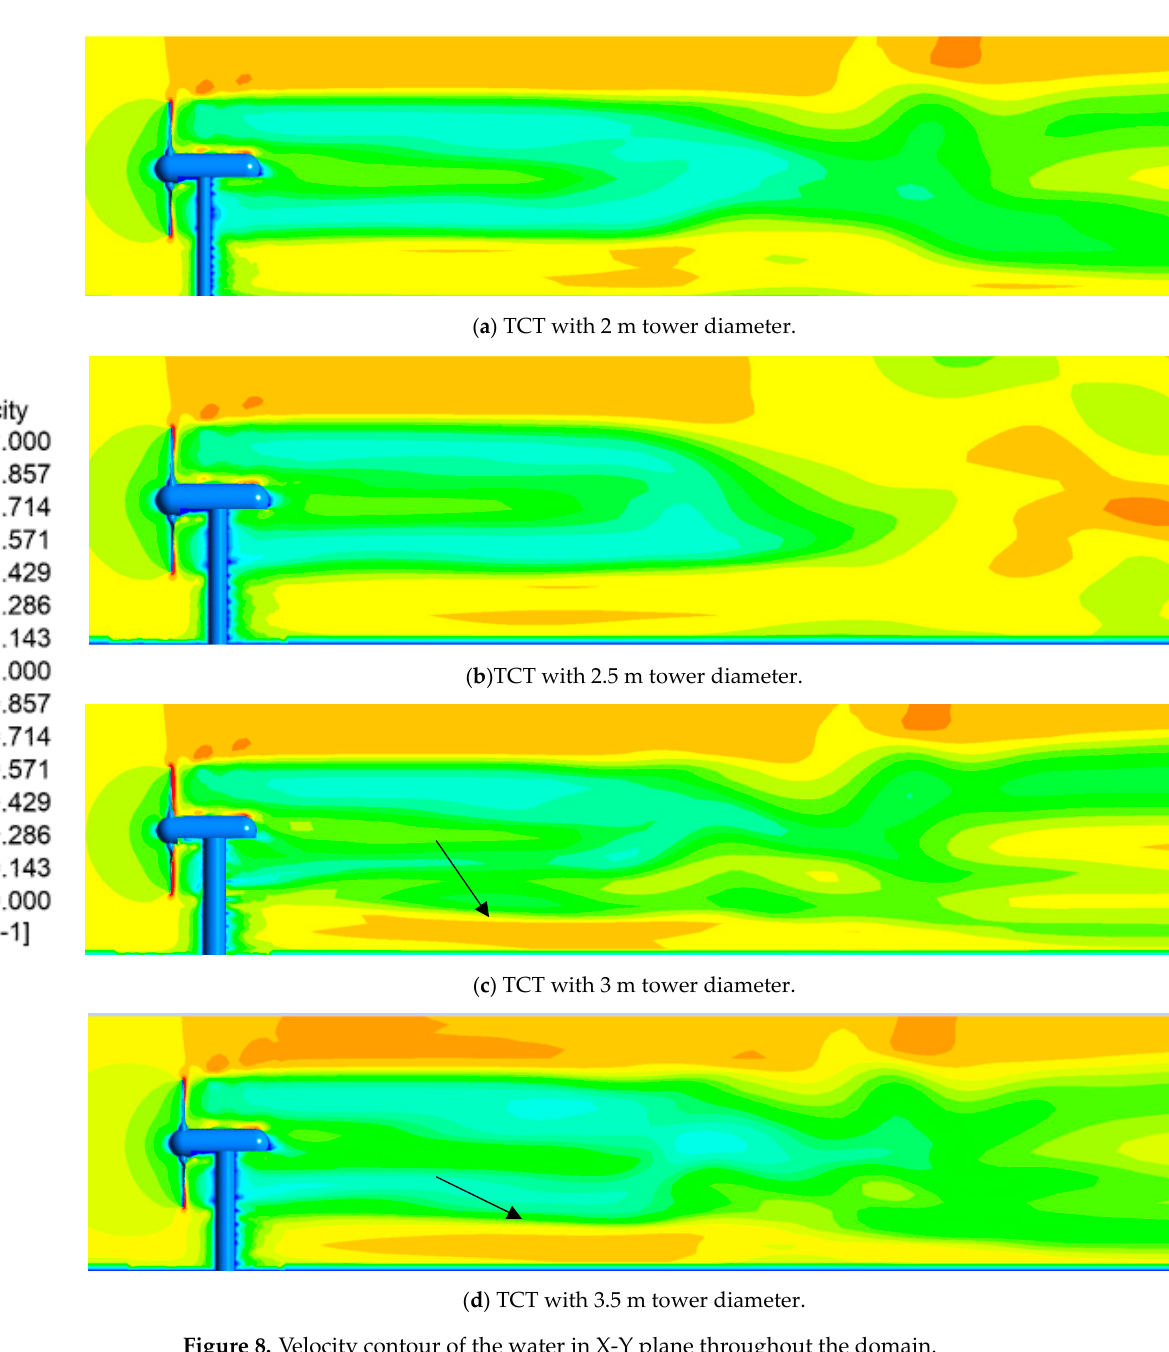
Figure 8. Velocity contour of the water in X-Y plane throughout the domain.